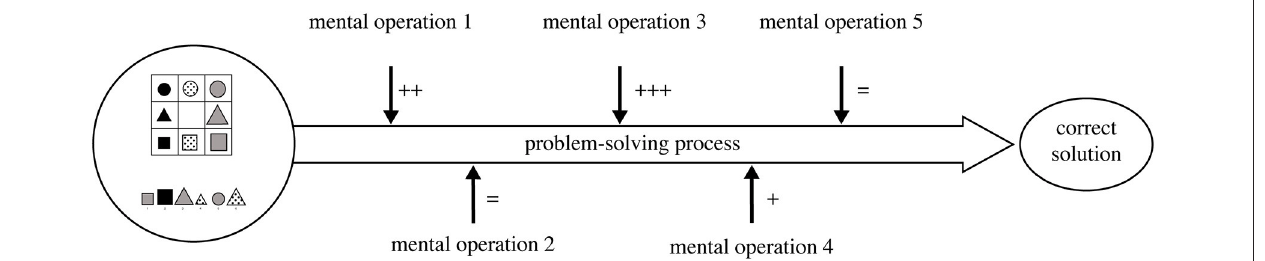
FIGURE 1 | Differing effects of isolated mental operations on correct